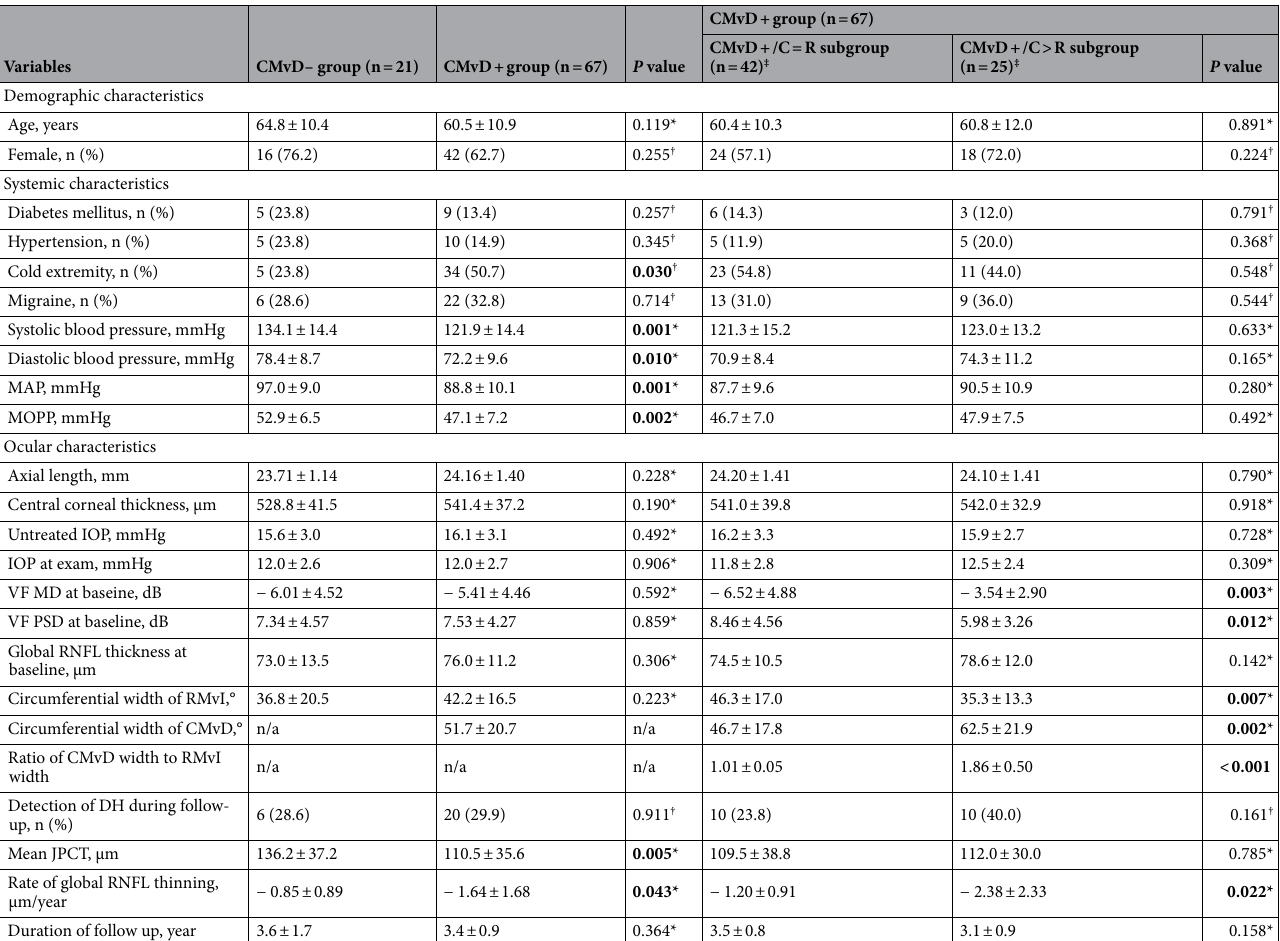
Table 1. Demographics and clinical characteristics of subjects. Values area mean ± standard deviation unless otherwise indicated. Values with statistical significance are shown in bold. CMvD choroidal microvasculature dropout, MAP mean arterial pressure, MOPP mean ocular perfusion pressure, IOP intraocular pressure, VF visual field, MD mean deviation, PSD pattern standard deviation, RNFL retinal nerve fiber layer, RMvI retinal microvascular impairment, n/a not applicable, DH disc hemorrhage, JPCT juxtapapillary choroidal thickness. *Comparisons were performed using independent samples t -test. † Comparisons were performed using Pearson’s chi -square test. ‡ Ratio of the circumferential width of CMvD to that of the RMvI, between 0.75 and 1.25 and > 1.25 were defined as CMvD + /C = R and CMvD + /C > R,